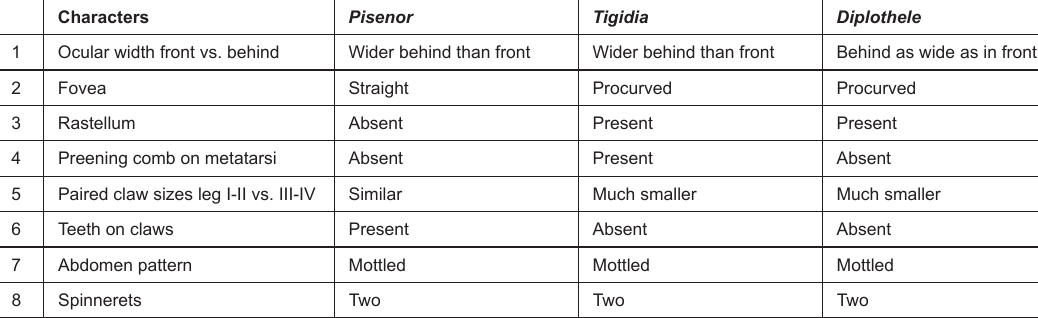
Table 1. List of characters distinguishing the three genera Pisenor , Tigidia and Diplothele